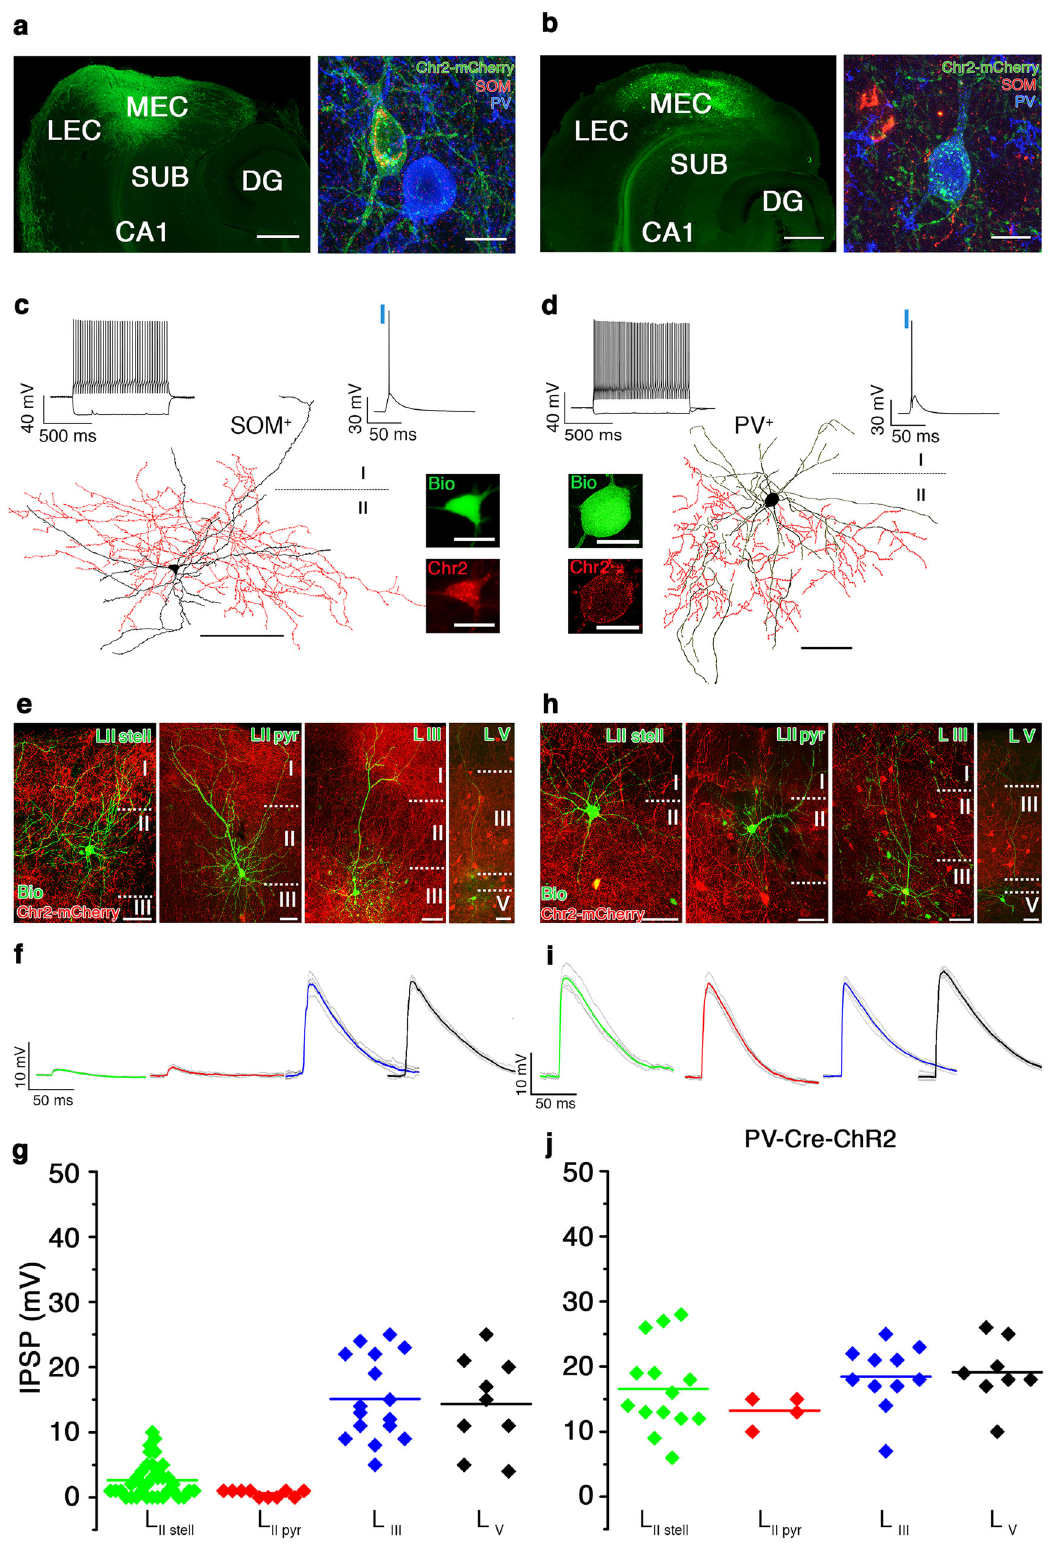
hyperpolarization 10,23,26 ) and pyramidal cells ( n = 4, N = 3 WFS1 + or calbindin + 10,27 ) responded with a fast, monosynaptic (2.17 ± 0.56 and 1.9 ± 0.6 ms delay time, respectively, p = 0.58) voltage change. These data are in agreement with previous reports investigating PV cell innervation onto layer II perisomatic-targeting neurons 11,23 . However, we found